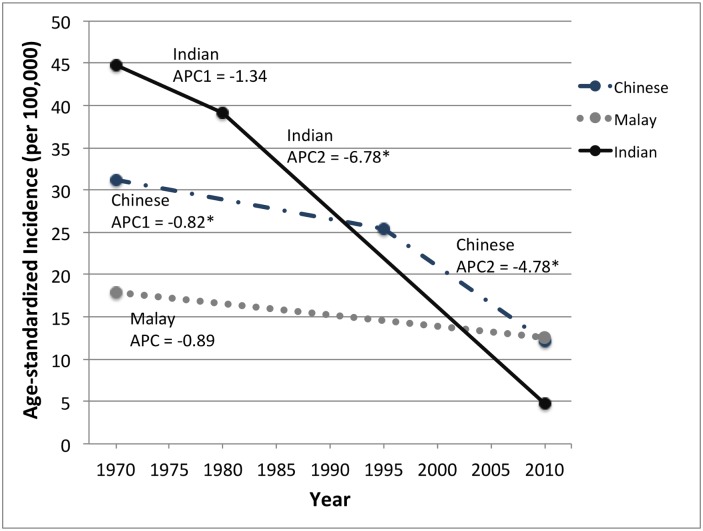
Incidence of invasive cervical cancer in Singapore, 1968–2012, by ethnicity.Incidence trends are based on incidence rates for 5-year time periods that were age-adjusted to the WHO standard population. Annual percent change (APC) was calculated using Joinpoint regression analysis. APC = annual percent change. An asterisk (*) indicates an APC value that is statistically significant at p≤0.05.